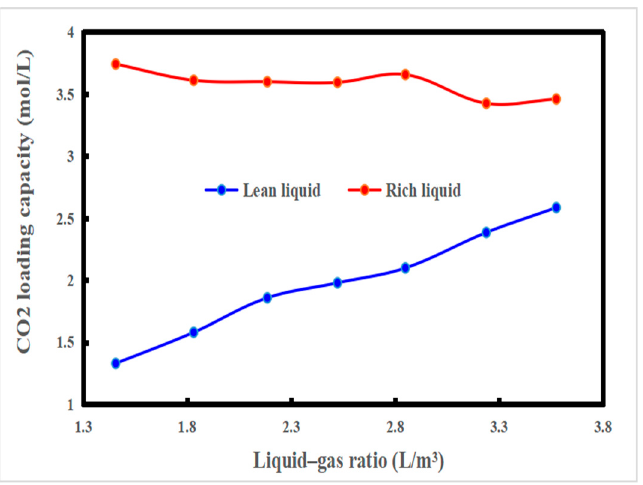
Figure 4. Effect of the liquid–gas ratio on the CO 2 loading capacity of lean and rich liquids.